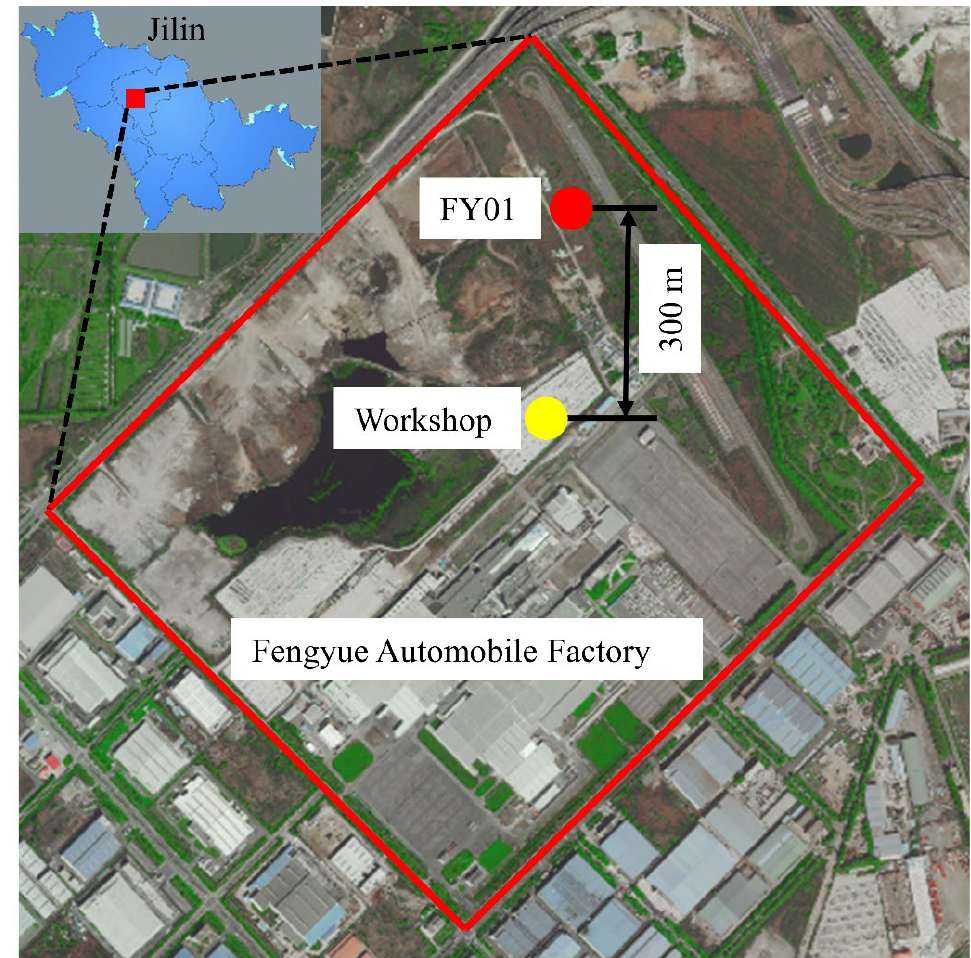
Figure 1. Regional and specific locations of the borehole and heating